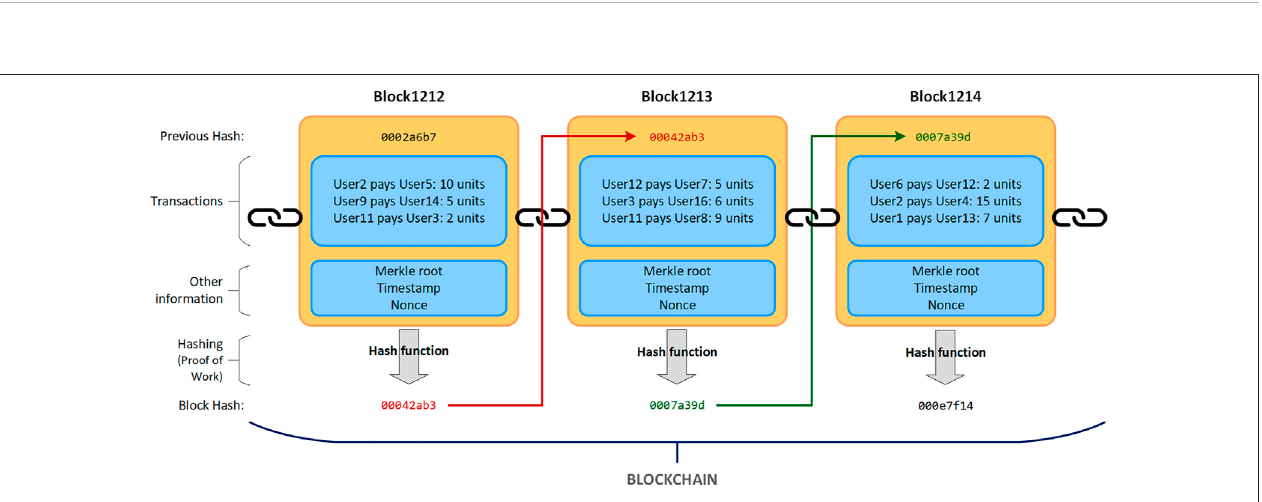
FIGURE 6 | An example of a simple